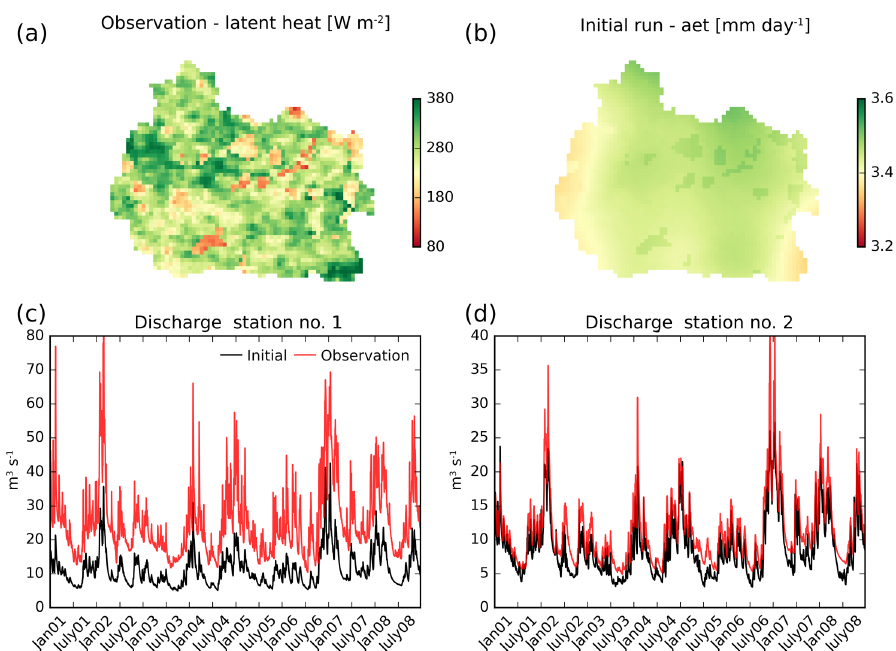
Figure 2. Reference data used for the optimization: the average cloud-free spatial pattern of midday latent heat in June (a) and observed discharge (red line) at two stations (shown in Fig. 1) for the 8-year simulation period (c, d) . Also shown are the simulation results from the initial parameter set: the average cloud-free spatial pattern of daily actual evapotranspiration (aet) in June (b) and the simulated discharge (black line) at the two reference